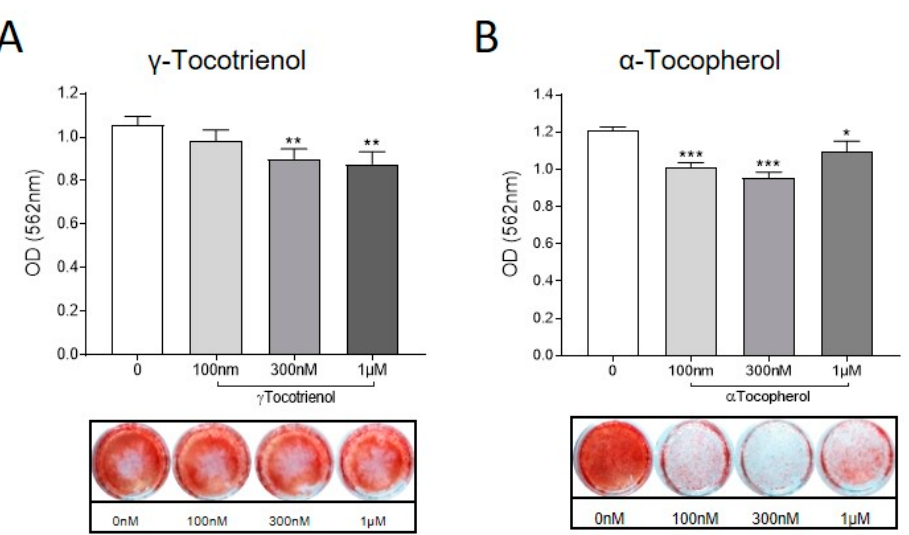
Figure 4. Effect of vitamin E analogues on osteocyte mineral handling. Human osteocyte-like cultures were treated with either ( A ) γ -Tocotrienol or ( B ) α -Tocopherol (100 nM, 300 nM, 1 µ M), or untreated (0) for a further 6 d. Cells were stained with Alizarin Red and then quantified using Cetylpyrridium chloride to elute the bound stain. Absorbance at 560 nM was measured by spectrophotometry. Data shown are means ± standard deviation of quadruplicate wells. Significant differences are denoted by * p < 0.05, ** p < 0.01, *** p < 0.001.